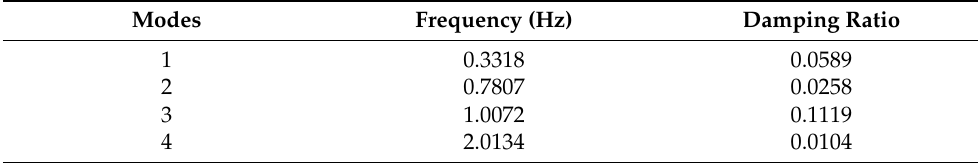
Table 2. Modal parameters of signal A identified with SSI